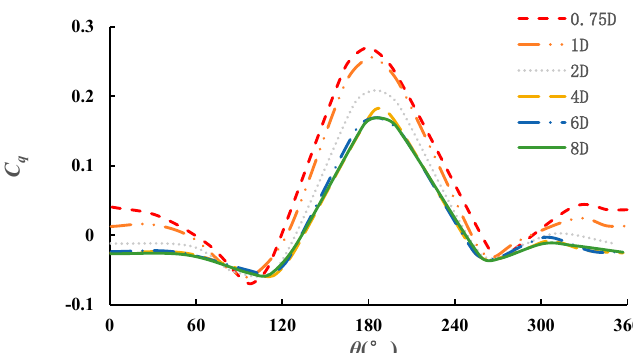
Figure 7. Variation trend of torque coefficient of single turbine with phase angle for three different timesteps